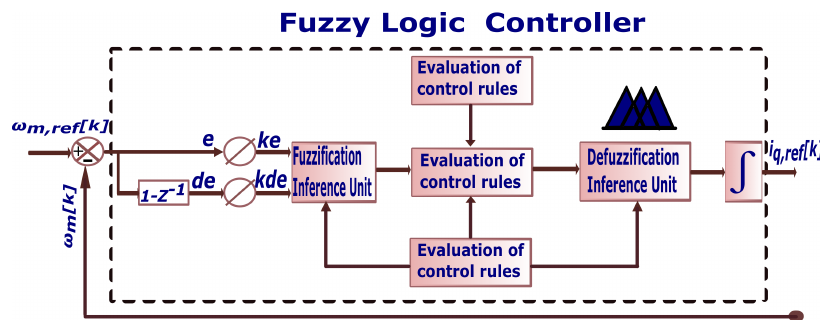
Figure 7. Fuzzy logic